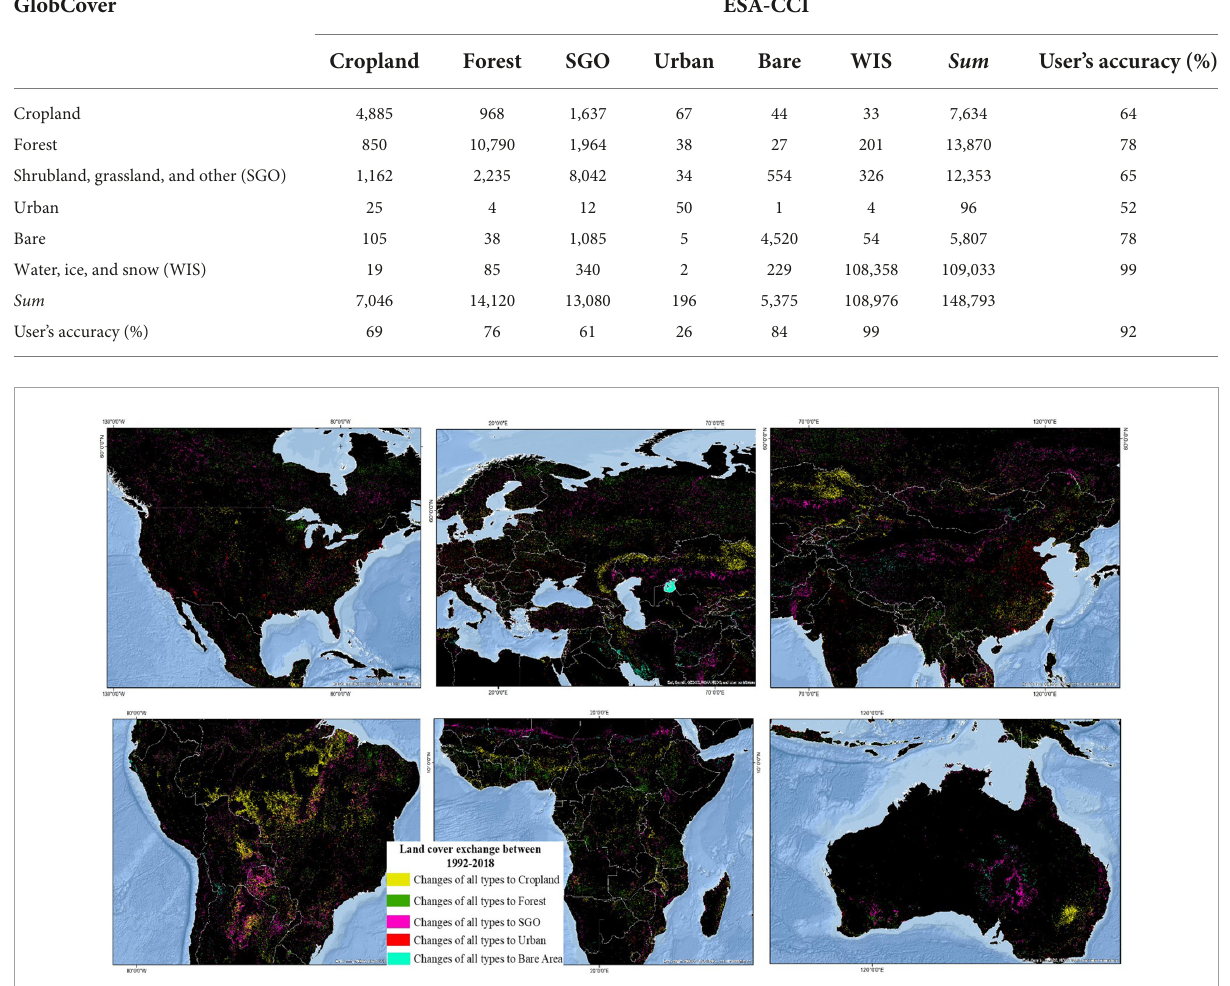
FIGURE3 Maps of land-cover Exchanges (changes from the initial type to any other type) during the full period of 1992–2018.